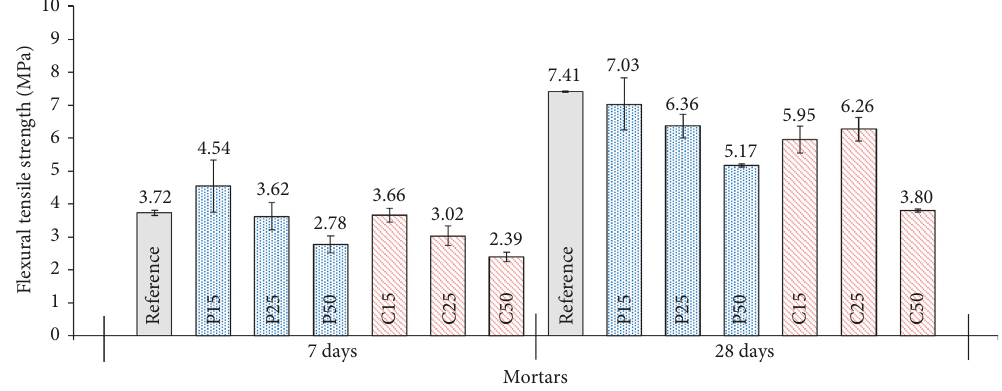
Figure 11: Flexural strength results. P: porcelain waste; C: ceramic waste.